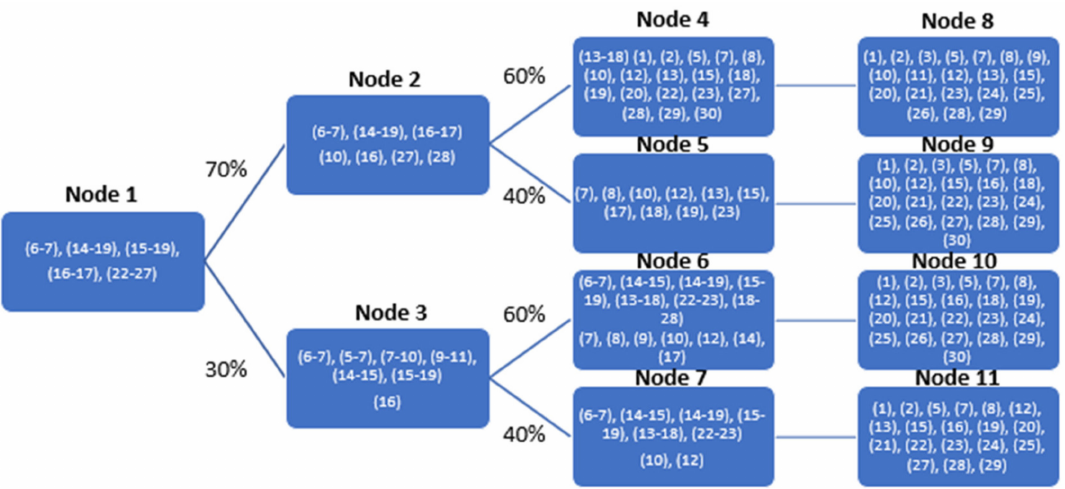
Figure 7. Optimal investment strategy for the case with conventional and energy storage investments. The notation (z) represents energy storage investment in bus (i.e., India state)